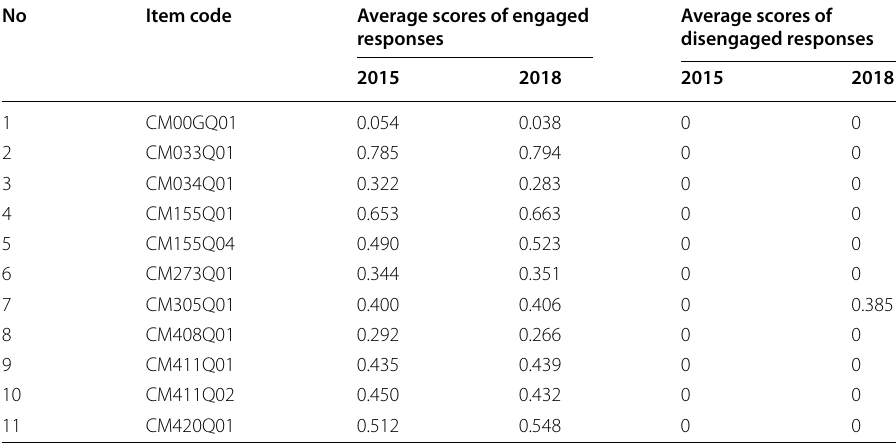
Table 4 Comparison of the scores of disengaged and engaged responses in 2015 and 2018. Source : Organisation for Economic Co-operation and Development (OECD), Programme for International Student Assessment (PISA), 2015 and 2018 Mathematics